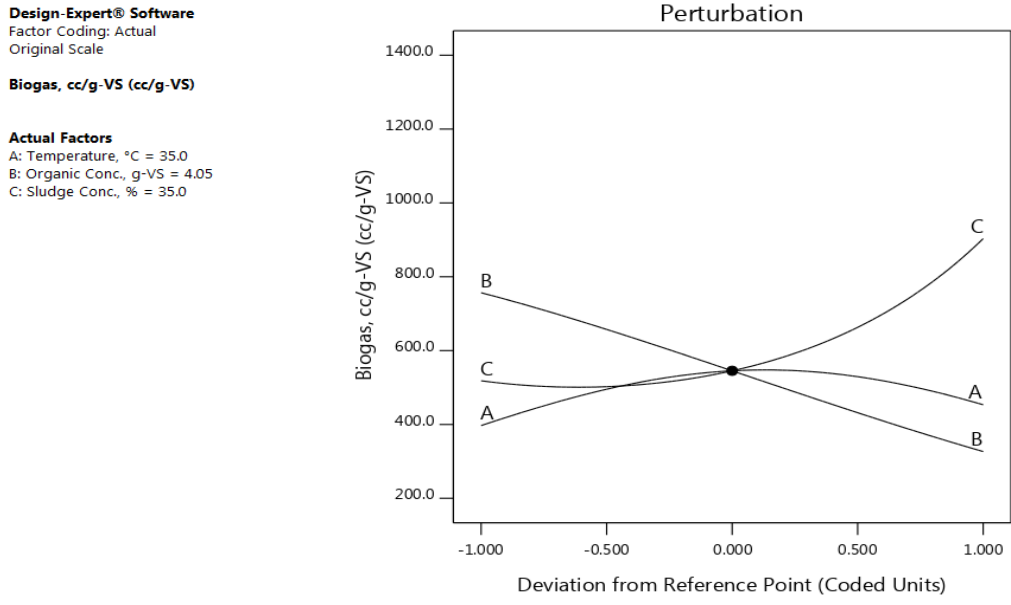
Figure 4. The Perturbation plot of the volume of biogas produced from g-VS/0.2 L.